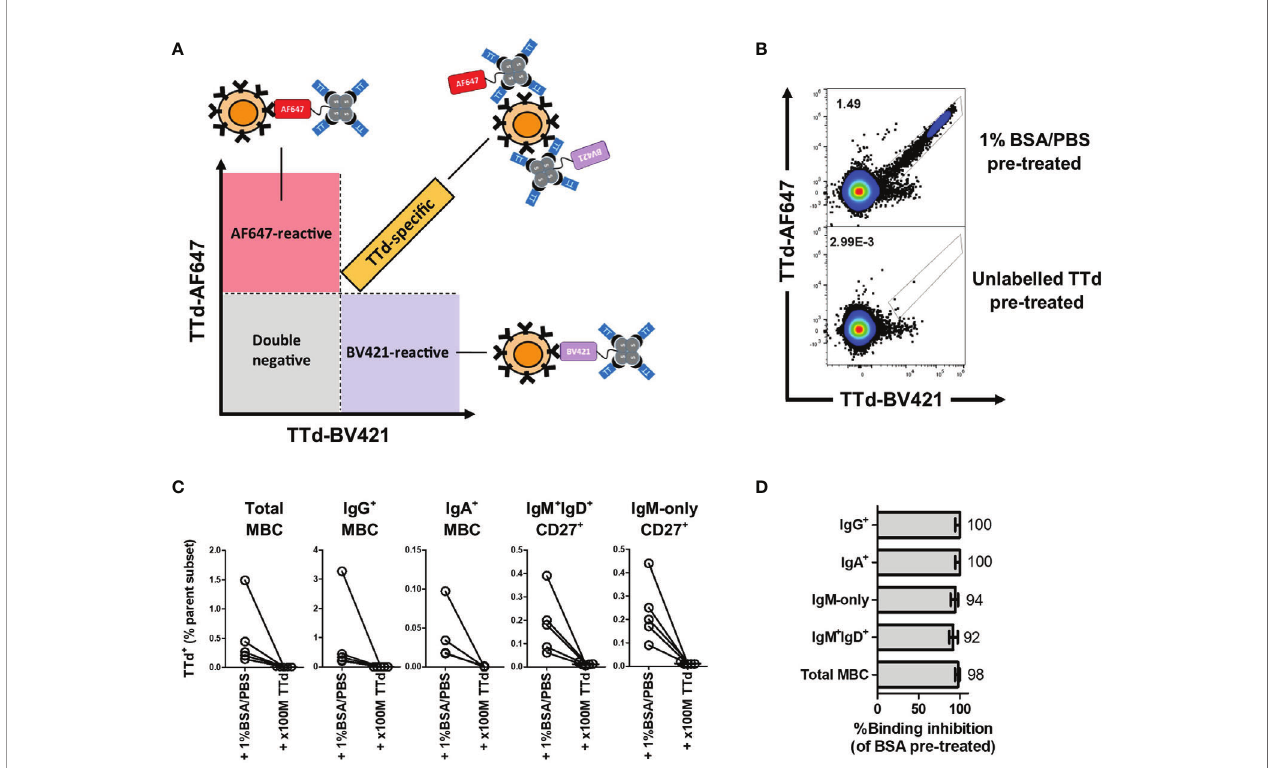
FIGURE 2 | B cell TTd tetramer-binding assay. (A) A diagram depicting the theoretical basis of the gating strategy. TTd binding events will bind with equal fl uorescence intensities to the tetramer and thus will align proportionally in the double positive quadrant of a TTd-AF647 vs. TTd-BV421 biaxial plot. In contrast, single-positive events represent fl uorochrome-reactive B cells, as these are events that bind one tetramer and not the other. (B) Representative scatterplot showing the effect of unlabelled TTd versus 1%BSA/PBS pre-treatment on dual TTd tetramer staining of day 14 post-ADT PBMC sample. (C) Pre-treatment with 100M excess of unlabelled TTd prior to addition of TTd tetramers to PBMC of 5 individuals 14 days following ADT vaccination demonstrates a near complete abolishment of TTd-AF647 + BV421 + events across all MBC subsets. (D) Median (range) of %TTd binding inhibition upon pre-treatment with unlabelled TTd, relative to 1%BSA/PBS pre-treated control, are shown for each